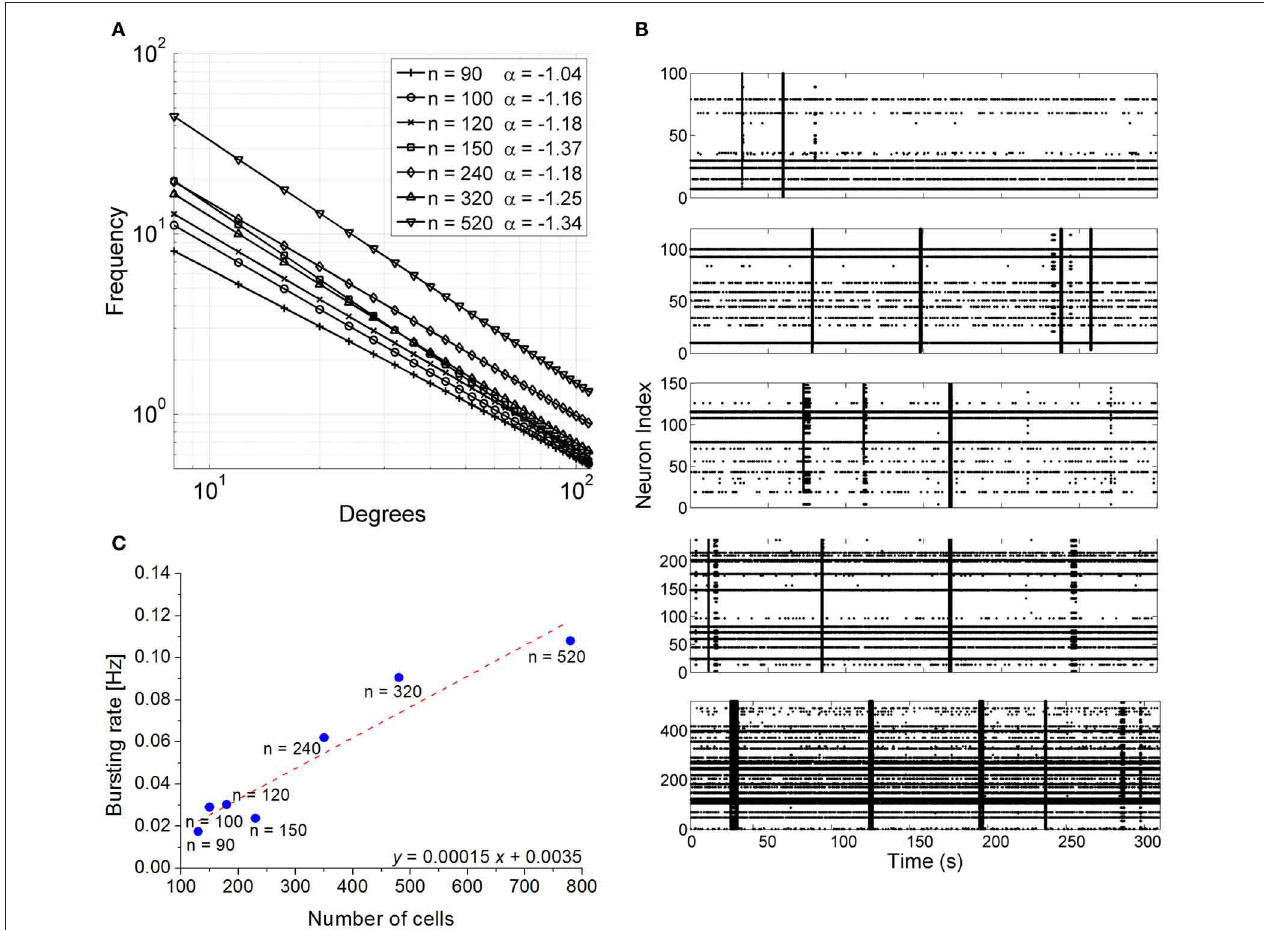
FIGURE 6 | Simulation results. (A) Degree distribution of the 7 scale-free networks. (B) Raster plots showing 300s of spontaneous activity of simulated confined networks. Each raster is relative to a different network size. From top to bottom networks with 100, 120, 150, 240, 520 neurons can be observed.. IFR profiles was evaluated over simulations lasting 600s (bin size = 100ms). (C) Bursting rate frequency as a function of network